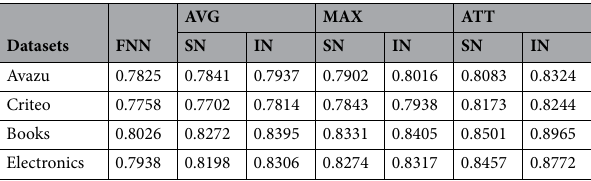
Table 4. AUC of SISA variants in different